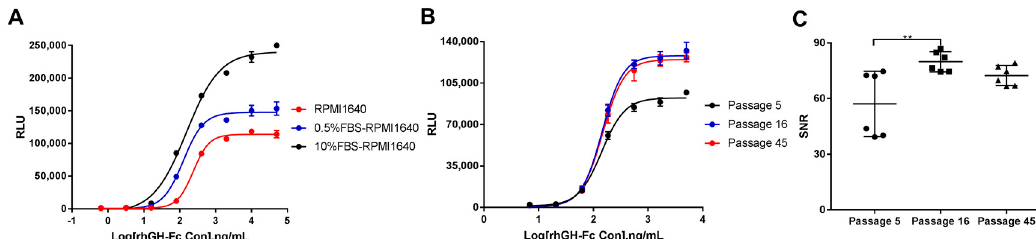
Figure 4. The robustness of the responsive HEK293-Luc cell line to rhGH-Fc. ( A ) The responsiveness of HEK293-Luc cells to rhGH-Fc in 0, 0.5%, and 10% FBS RPMI 1640 assay media. ( B ) The sigmoidal curves of HEK293-Luc cells responded to rhGH-Fc at passage 5, passage 16, and passage 45. ( C ) The SNRs of HEK293-Luc cells responded to rhGH-Fc at passage 5, passage 16, and passage 45. ** p < 0.01.